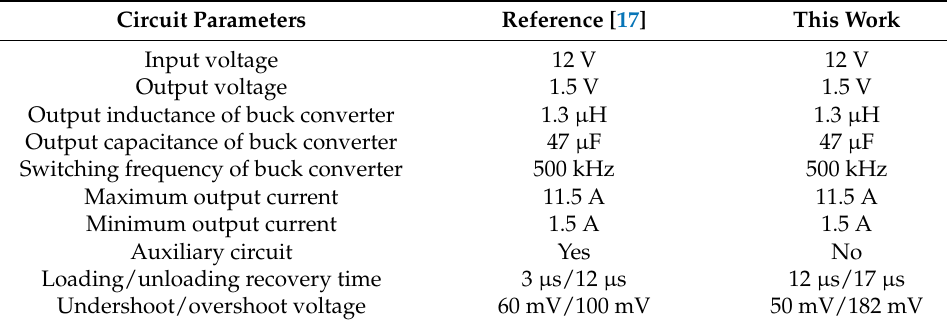
Table 4. Comparison with Reference [17].